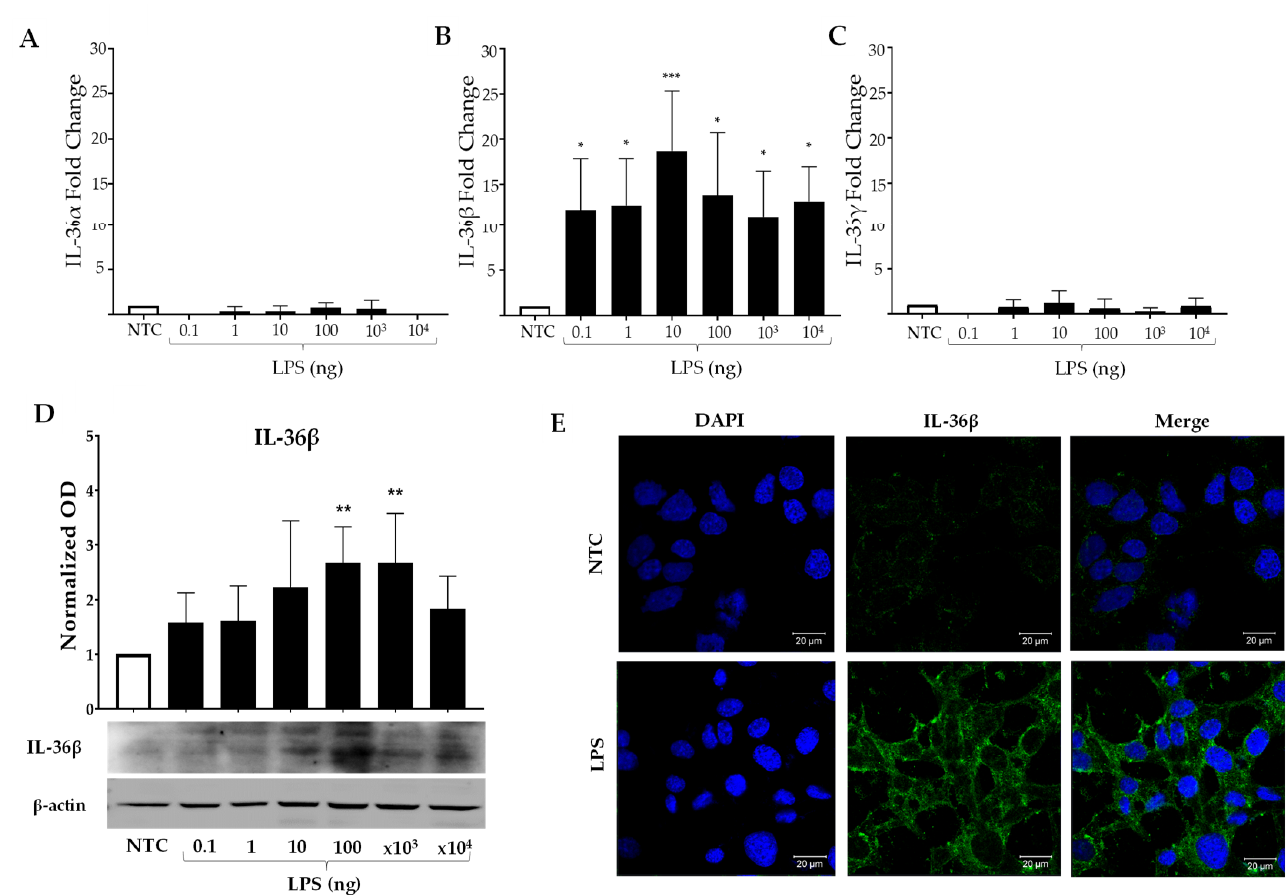
Figure 2. LPS stimulation triggers a differential expression of IL-36 β in MCs. MES SV40 cells (1.5 × 10 6 ) were stimulated in 2 mL of medium containing different amounts of LPS for 2 h, and the expression of ( A ) IL-36 α ; ( B ) IL-36 β ; ( C ) IL-36 γ mRNA was measured. The expression was normalized against Actb, and the fold change was calculated in comparison with the respective non-stimulated control (NTC). ( D ) Mesangial cells were stimulated for 6 h, and total protein was extracted for Western blot performance. The intensity of the bands was quantified, normalized against β -actin, and the fold change was calculated. E) Representative image of IL-36 β production (stained green) in MES SV40 cells stimulated with 100 ng of LPS. The results were obtained from at least 3 independent experiments and are listed as mean ± SD. Data were analyzed with one-way ANOVA followed by Dunnett´s analysis. * p < 0.05 , ** p < 0.01 , *** p < 0.001 .